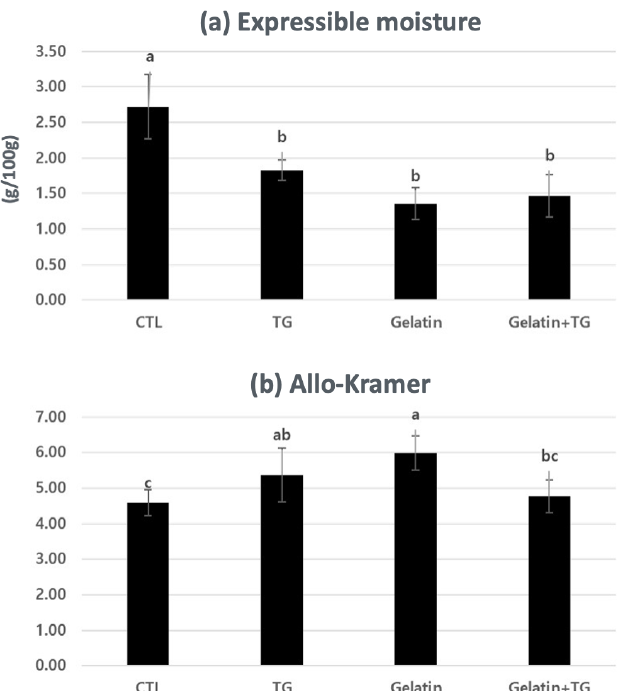
Figure 5. Expressible moisture ( a ) and Allo–Kramer value ( b ) of restructured ham with gelatin and transglutaminase. a–c Means ( n = 3) with the same superscripts in the same row are not different ( p > 0.05). The sensory attributes of the RH with gelatin and TGase are shown in Table 3.